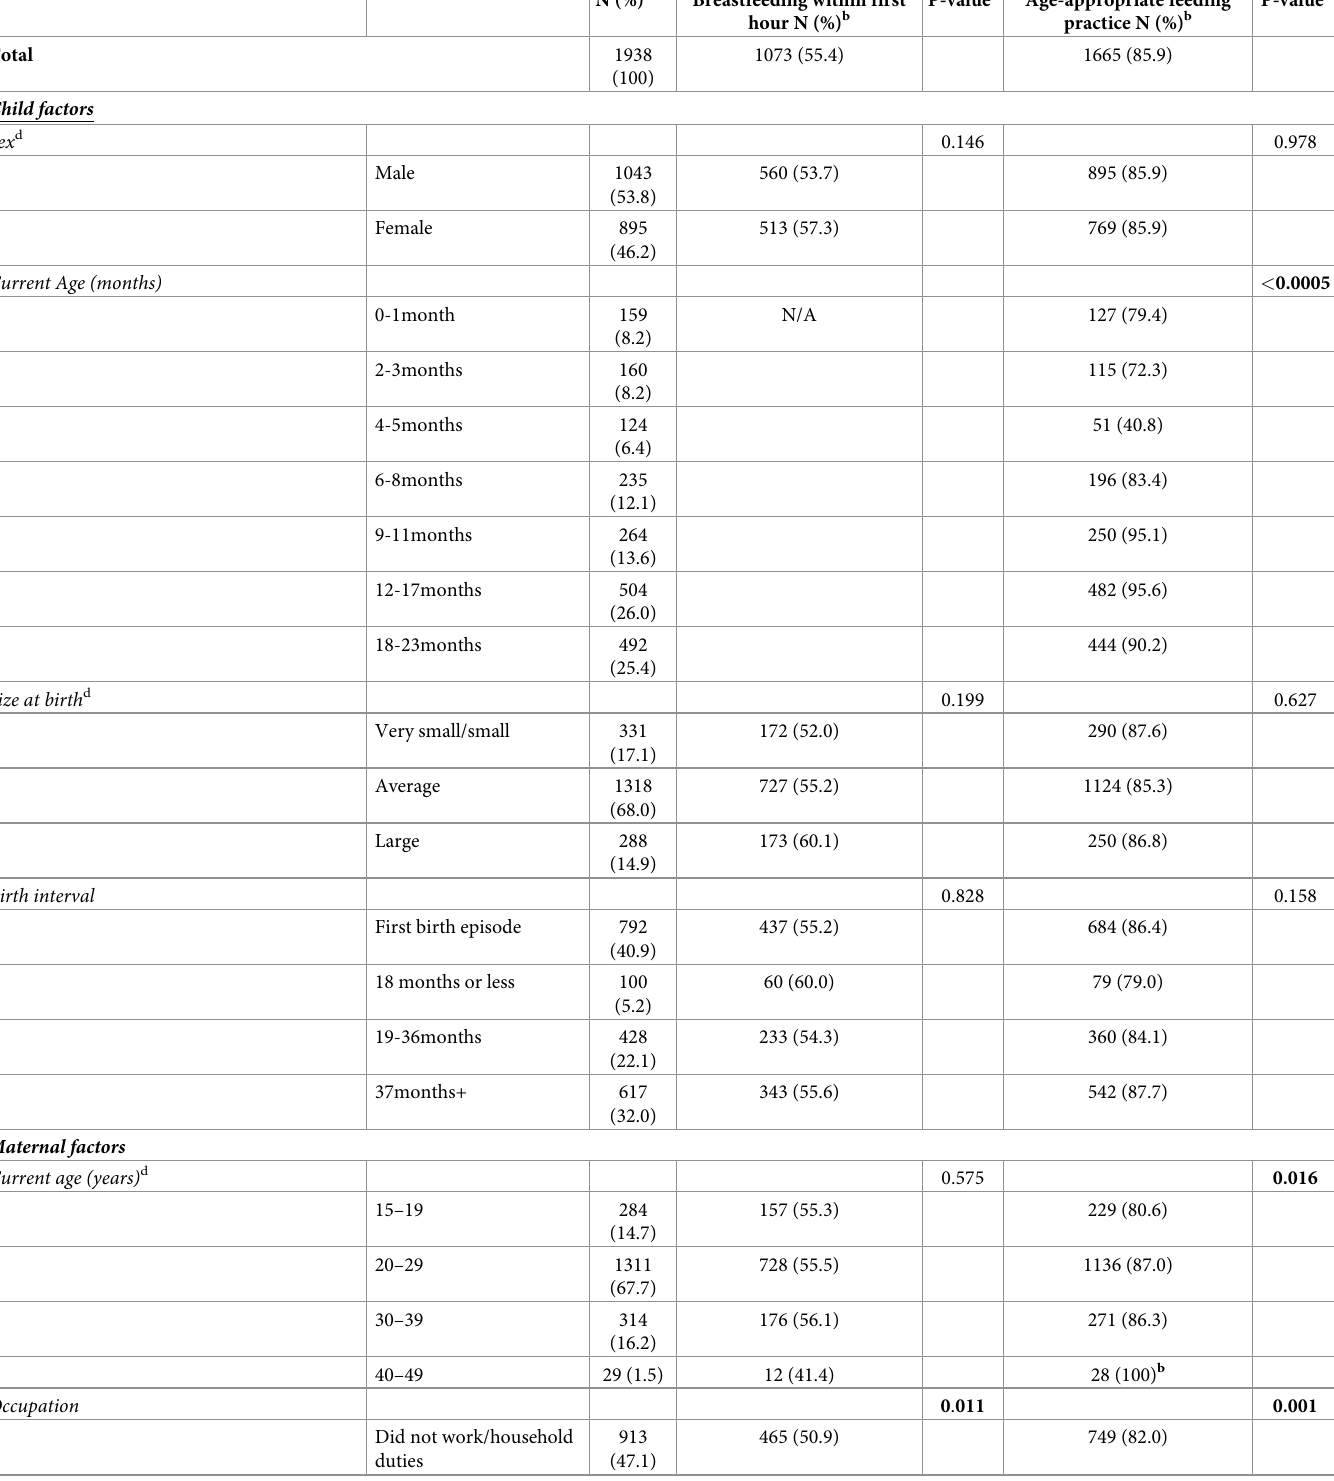
Table 1. Characteristics of the sample population and distribution of factors influencing breastfeeding within the first hour of birth and age-appropriate infant and young child feeding (IYCF)